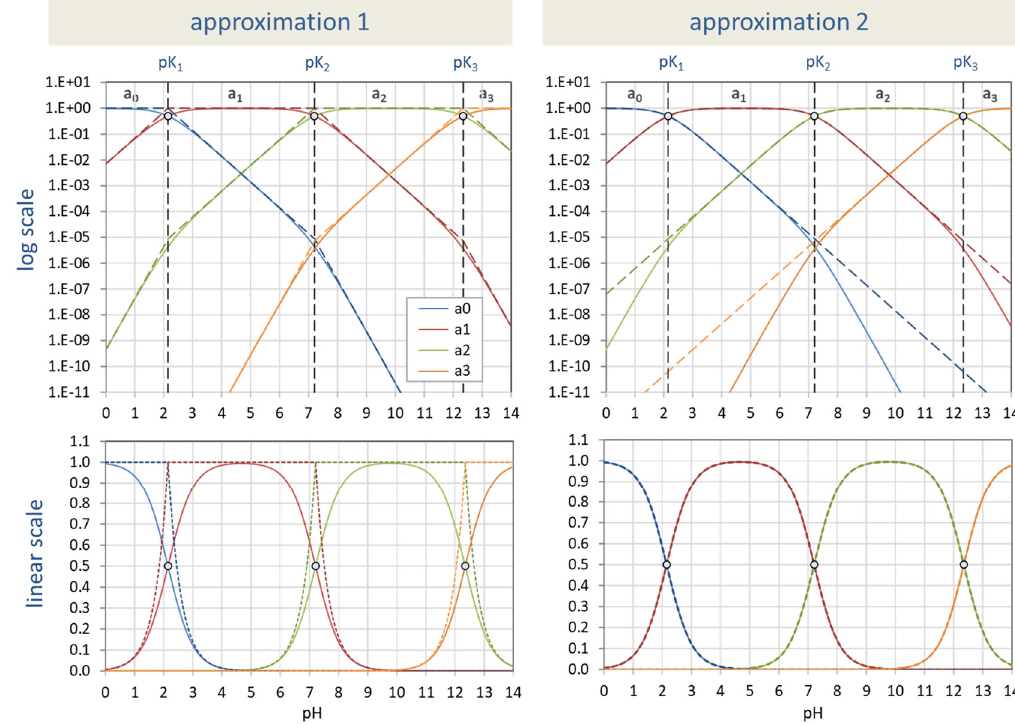
Figure 29. Ionization fractions for phosphoric acid in two approximations (dashed lines) vs. exact description based on Equation (17).